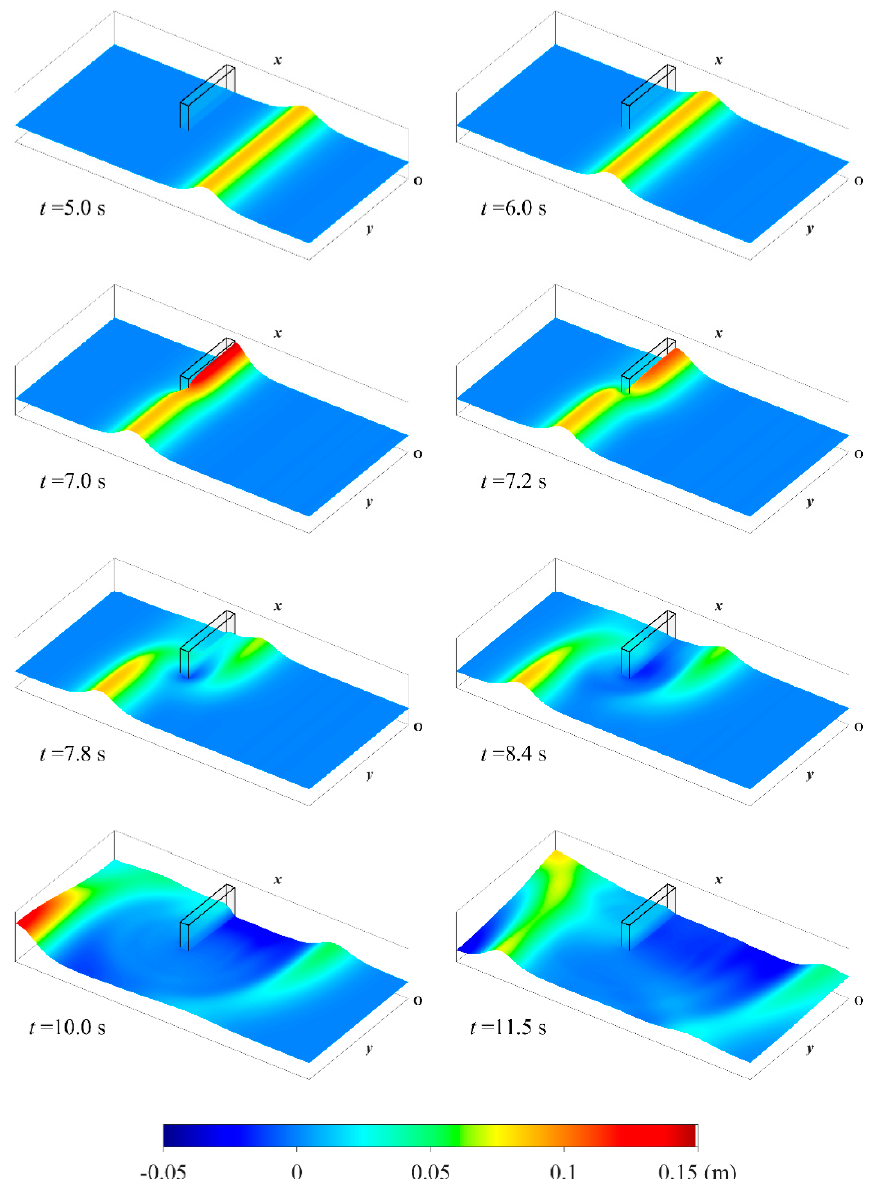
Figure 11. Free surface elevation at different instants for solitary wave interaction with a porous structure (wave propagates from right to left in each subfigure).